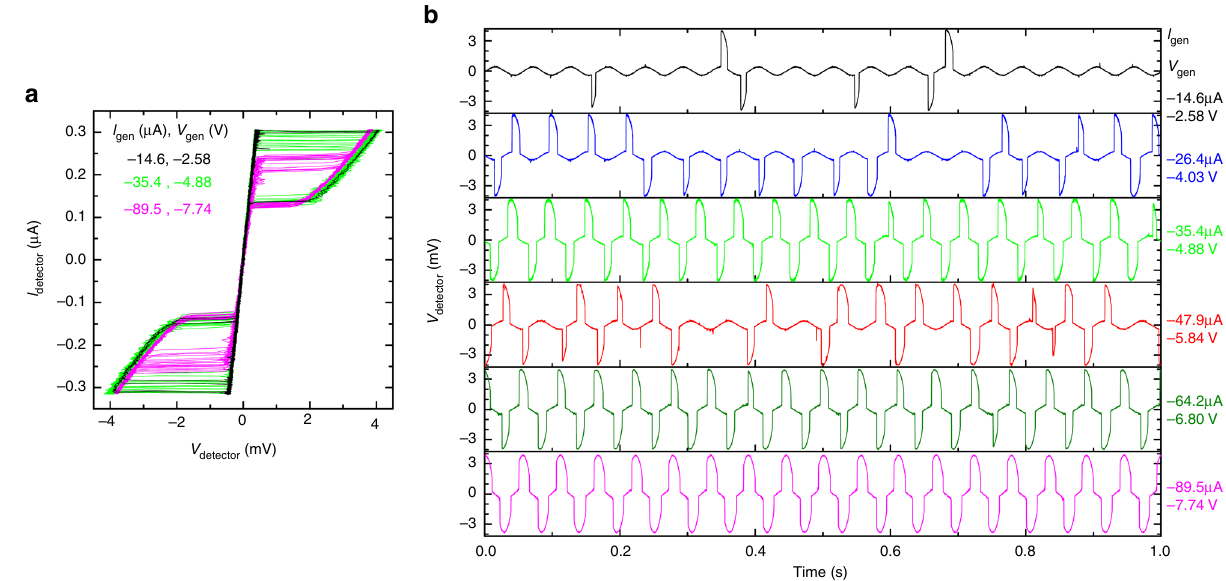
Fig. 2 Operation of a switching current detector. a I – V characteristics of a top junction in the detector mesa #5 for different biases in the generator mesa #2. b Time dependence of the detector voltage. Different panels from top to bottom correspond to increasing negative bias in the generator. The number of voltage pulses re fl ect the switching probability. It is seen that the switching probability changes non-monotonously with the generator bias. The